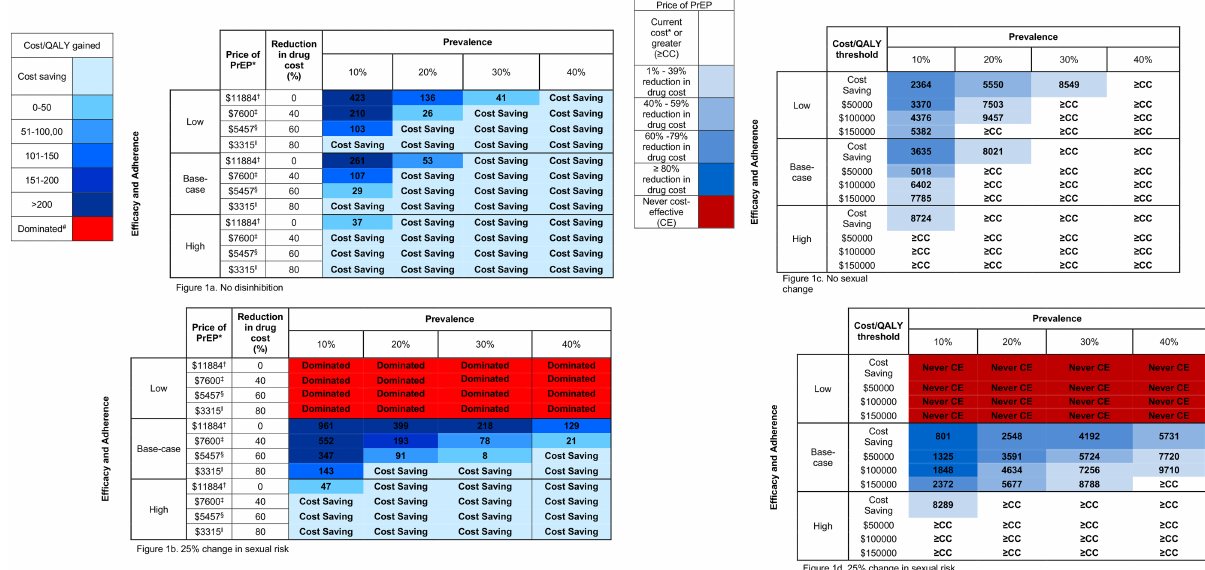
Fig 1. a-b: Incremental cost-effectiveness of PrEP (cost per QALY gained in thousands of US$) * Combines drug cost, physician visits, and laboratorytesting: drug cost: $10711/year, cost of physicianvisits: $1035/year, cost of renal function test: $30/year, cost of HIV testing: $108/year † Drug cost: $10711/year ‡ Drug cost: $6427/year §D rug cost: $4284/year k Drug cost: $2142/year # Dominatedrefers to cost-effectiveness scenarioswith highercost and worse outcomes. c-d: PrEP drug cost stratified by cost per QALY threshold. * Current drug cost estimated at $10711.